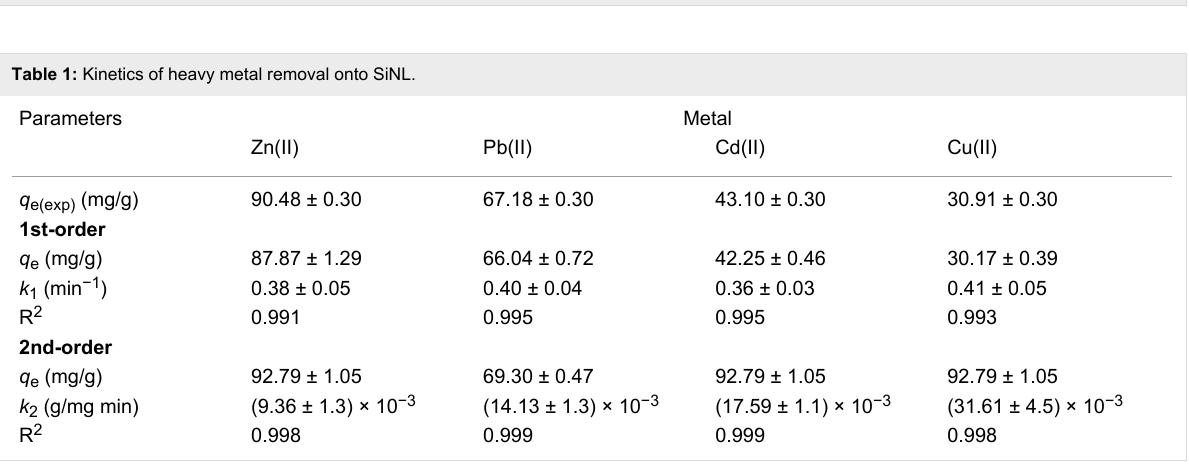
Figure 7: Pseudo-first-order and pseudo-second-order models fits for the adsorption of Zn(II), Pb(II), Cd(II) and Cu(II) ions by SiNL. Adsorption dose: V = 10 mL, m = 10 mg of SiNL using optimum pH (pH 6), optimum concentration (100 ppm in each case), and at 25 °C, ∆ q e = 0.3 (mg·g − 1 ).